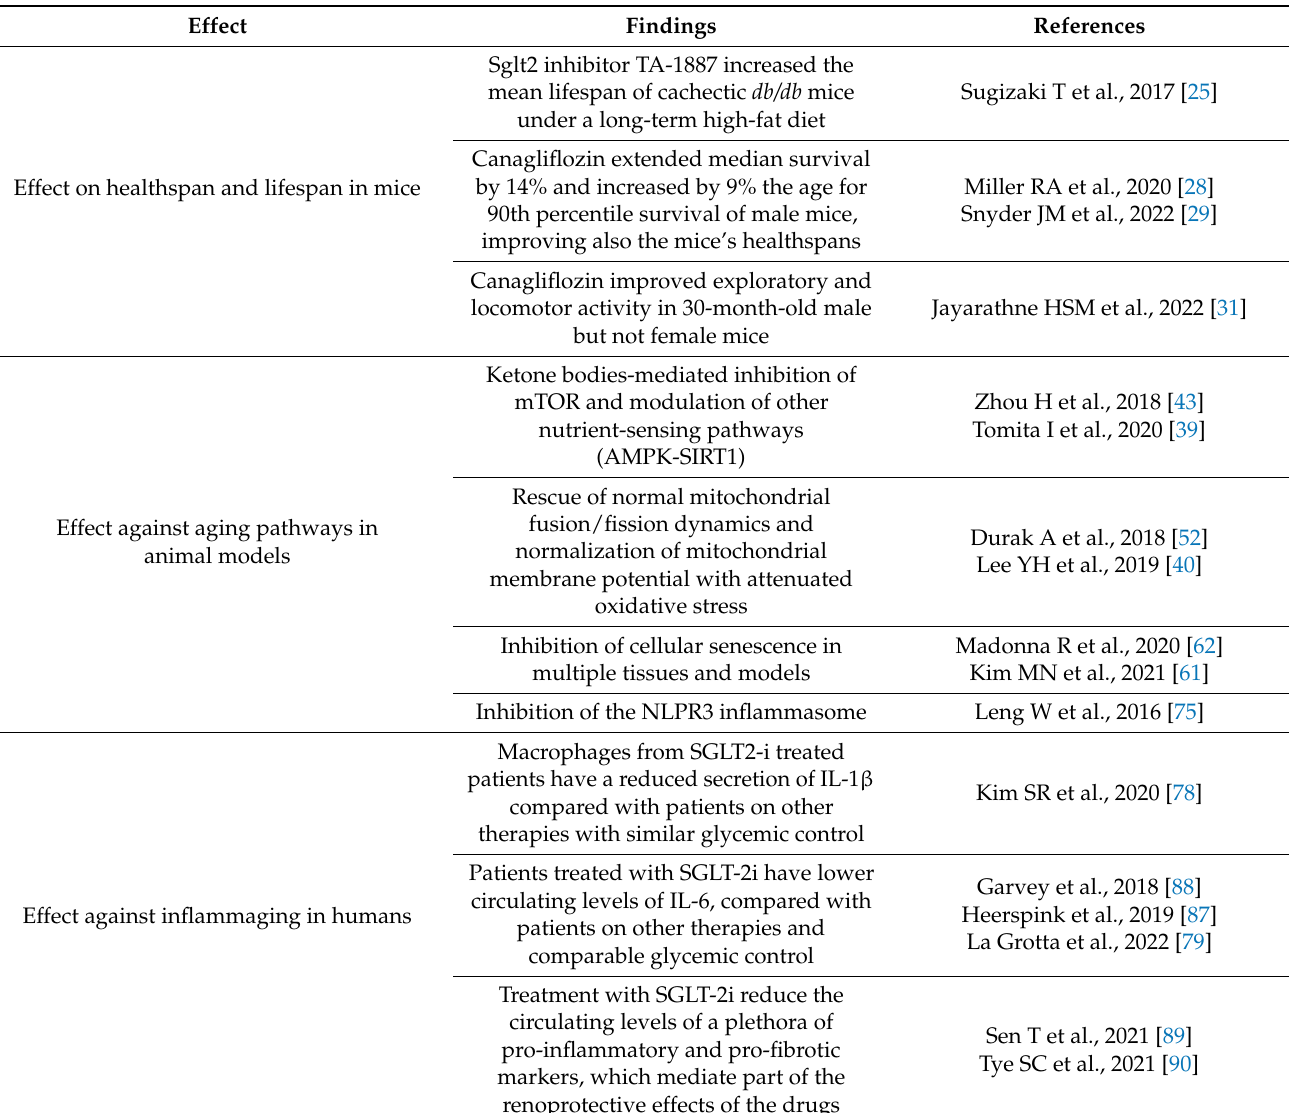
Table 1. Summary of the main findings relative to the effects of SGLT-2i on: 1- lifespan and healthspan in mice; 2- aging pathways in animal models; 3- markers of inflammaging in humans; and 4- the incidence of age-related diseases in patients with or without